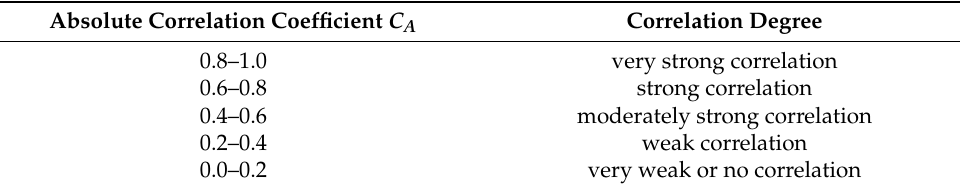
Table 2. Relationship between C A and correlation